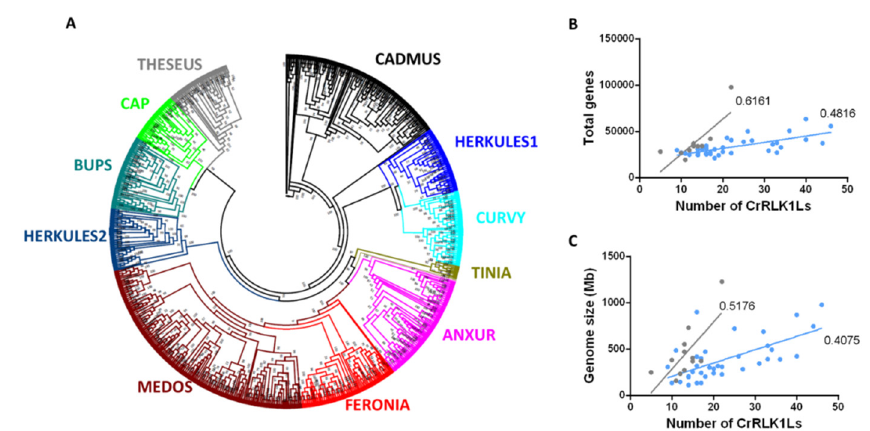
Figure 1. Phylogenetic relationship among 1050 CrRLK1L proteins and the relationship between CrRLK1L number versus gene size and gene number. ( A ) Unrooted approximately maximum-likelihood phylogenetic tree inferred from the 1050 CrRLK1L proteins present in 57 plant species. The clades, indicated in different colors, are named based on the A. thaliana CrRLK1L names. The CADMUS clade contains uncharacterized CrRLK1Ls from A. thaliana , and the TINIA clade corresponds to a clade formed only with the CrRLK1L proteins of S. moellendorffii , S. fallax , P. patens , and M. polymorpha . The phylogenetic tree was constructed using IQ-TREE software with the JTT+F+R10 substitution model with 1000 bootstrap iterations. ( B ) Relationship between total number of genes within the genome and number of CrRLK1L genes for monocotyledons (gray) and eudicots (blue). ( C ) Relationship between genome size and number of CrRLK1L genes for monocotyledons (gray) and eudicots (blue).